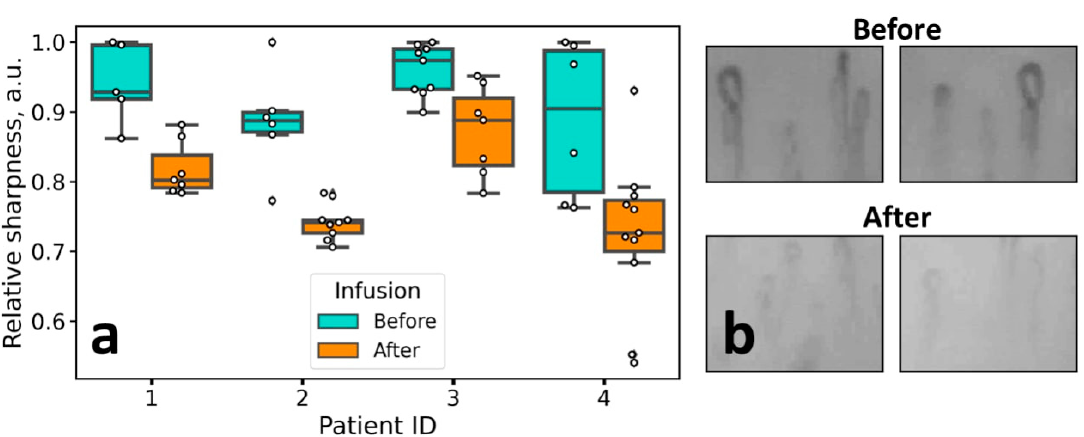
Figure 7. ( a ) Changes of the NVC image sharpness in patients before and after infusion therapy. Each dot corresponds to a single capillary. ( b ) Representative images of the capillaries before and after infusion therapy (after 3 L of infusion).